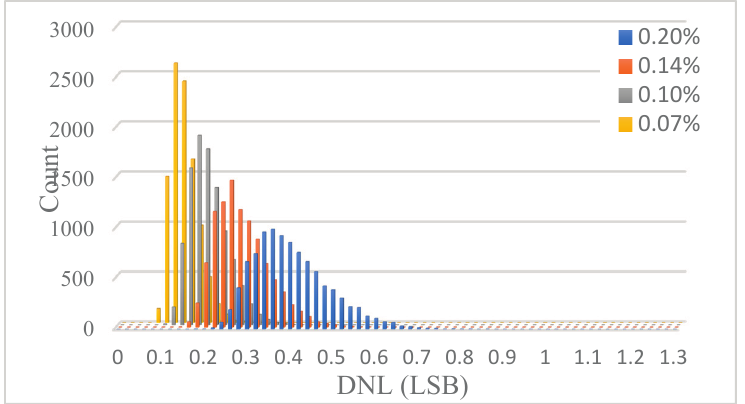
Figure 13. DNL Histogram of 10,000 Monte Carlo simulations for some different σ 0 / C 0 .